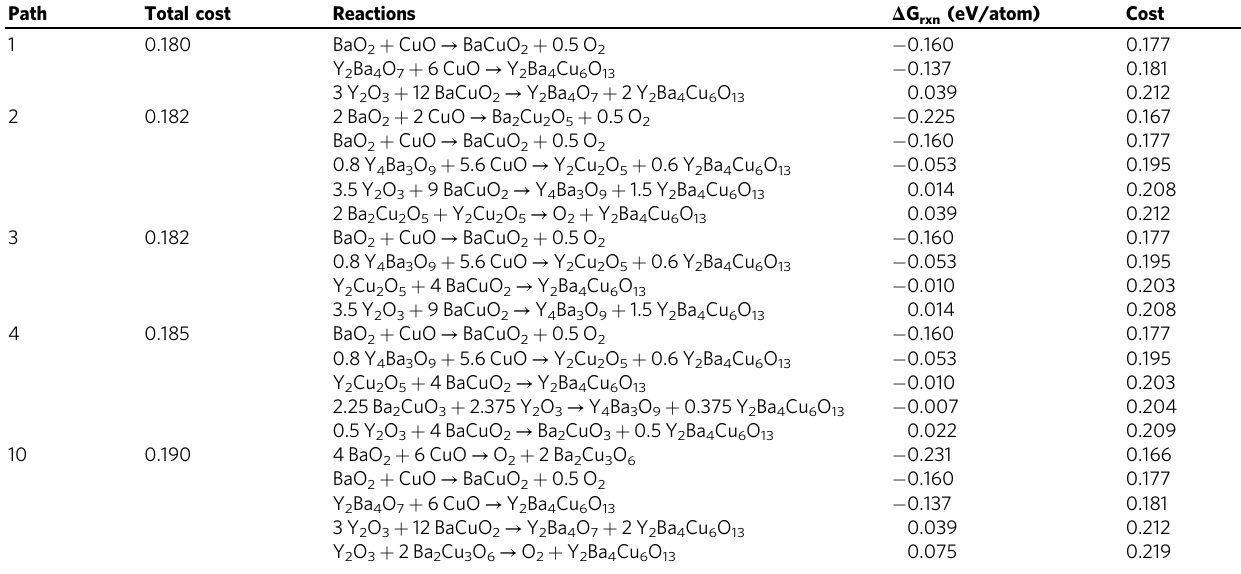
Table 4 Selection of top predicted reaction pathways to YBa 2 Cu 3 O 6.5 (shown here as Y 2 Ba 4 Cu 6 O 13 ).